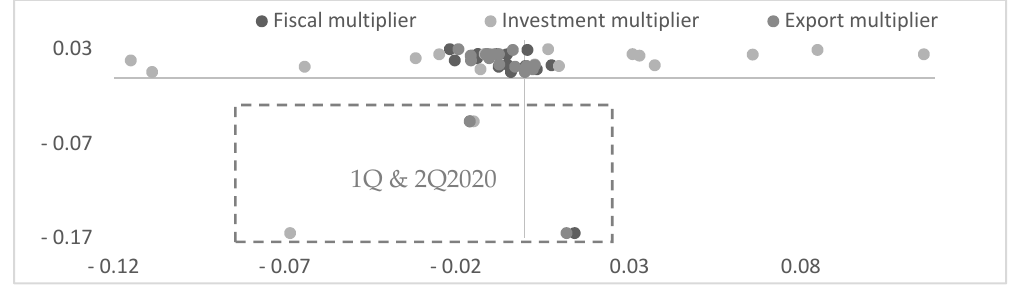
Figure 13. Correlation of changes in autonomous expenditure multipliers to GDP—Italy, own work, source: Eurostat.